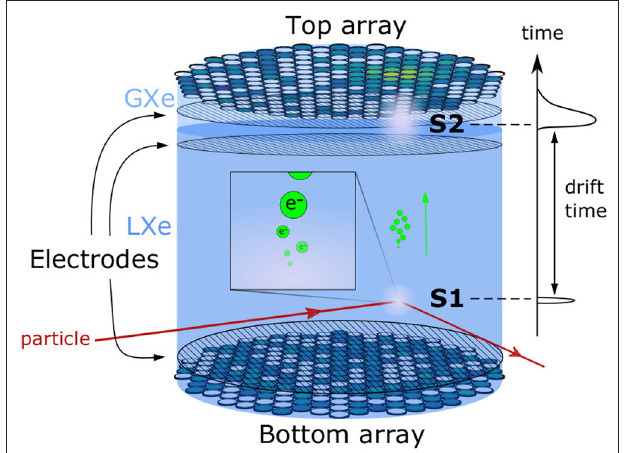
FIGURE 1 | A schematic of the working principle of a DP-LXe TPC detector. Particles interact and deposit energy in liquid xenon target. An S1 signal is produced at the interaction location. Ionization electrons are released from the interaction point and drift toward the top of the TPC, where an S2 signal is produced and